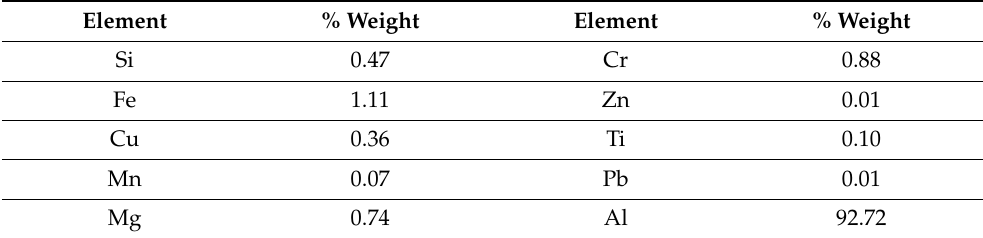
Table 1. Chemical composition (% by weight) of AlMgSi1 alloy.